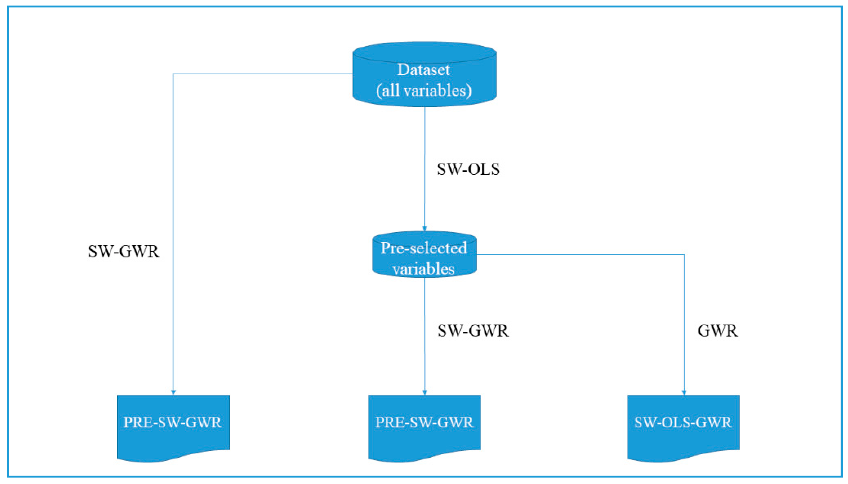
Figure 1. Steps for performing the three model selection